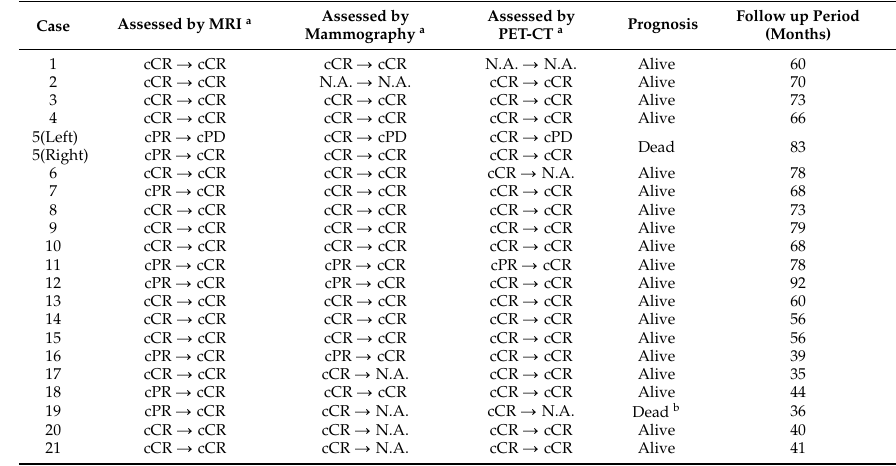
Table 3. Summarized data for all patients.